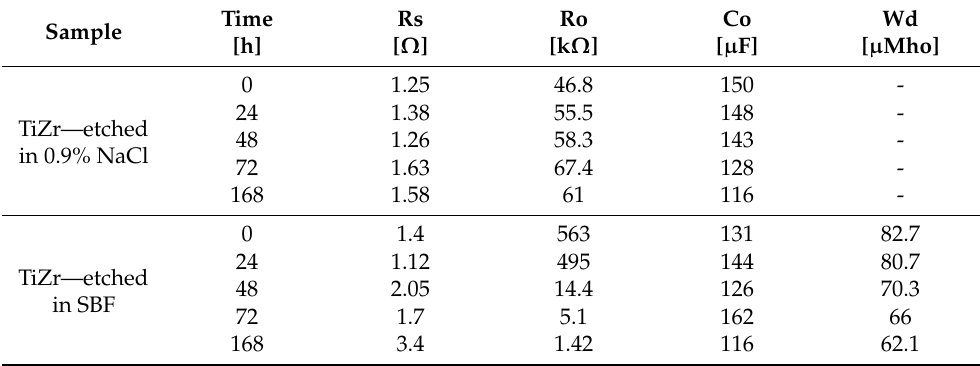
Figure 4. Nyquist, Bode Phase plots and equivalent circuits for etched TiZr in ( a ) 0.9% NaCl; ( b ) SBF. Table 3. Equivalent circuit values for etched TiZr in 0.9% NaCl and SBF.